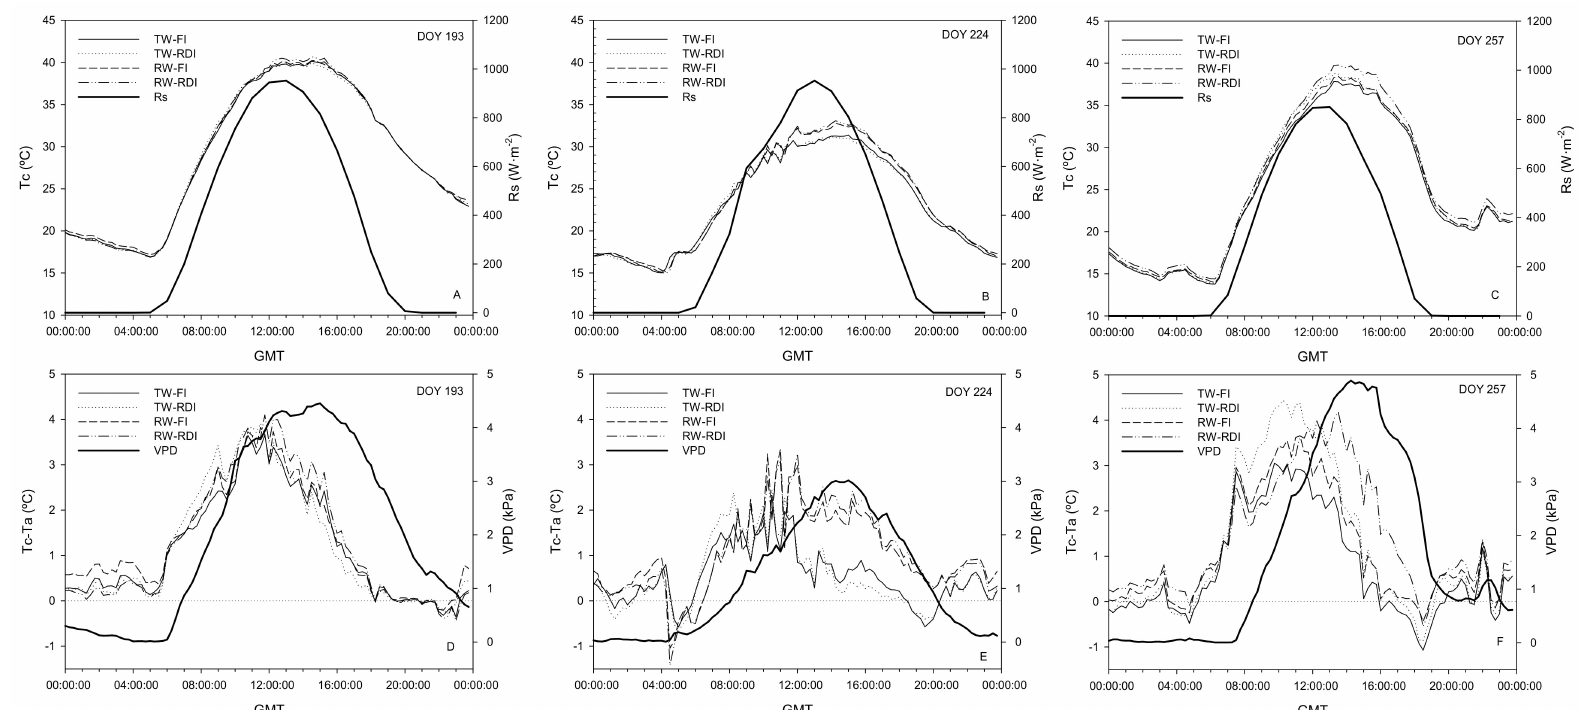
Figure 2. Representative diurnal course patterns of canopy temperature, Tc ( ◦ C) and evolution of solar radiation, Rs (W · m − 2 ) (top row: ( A–C )) and representative diurnal course patterns of Tc-Ta ( ◦ C) and evolution of VPD (kPa) (bottom row: ( D – F )) for each treatment: TW-FI (transfer water-full irrigation), TW-RDI (transfer water-regulated deficit irrigation), RW-FI (reclaimed water-full irrigation) and RW-RDI (reclaimed water-regulated deficit irrigation) on three days that differed in tree water status: DOY 193, 224, and 257 in 2017. Each Tc reading corresponded to the averaged value from four trees of the same